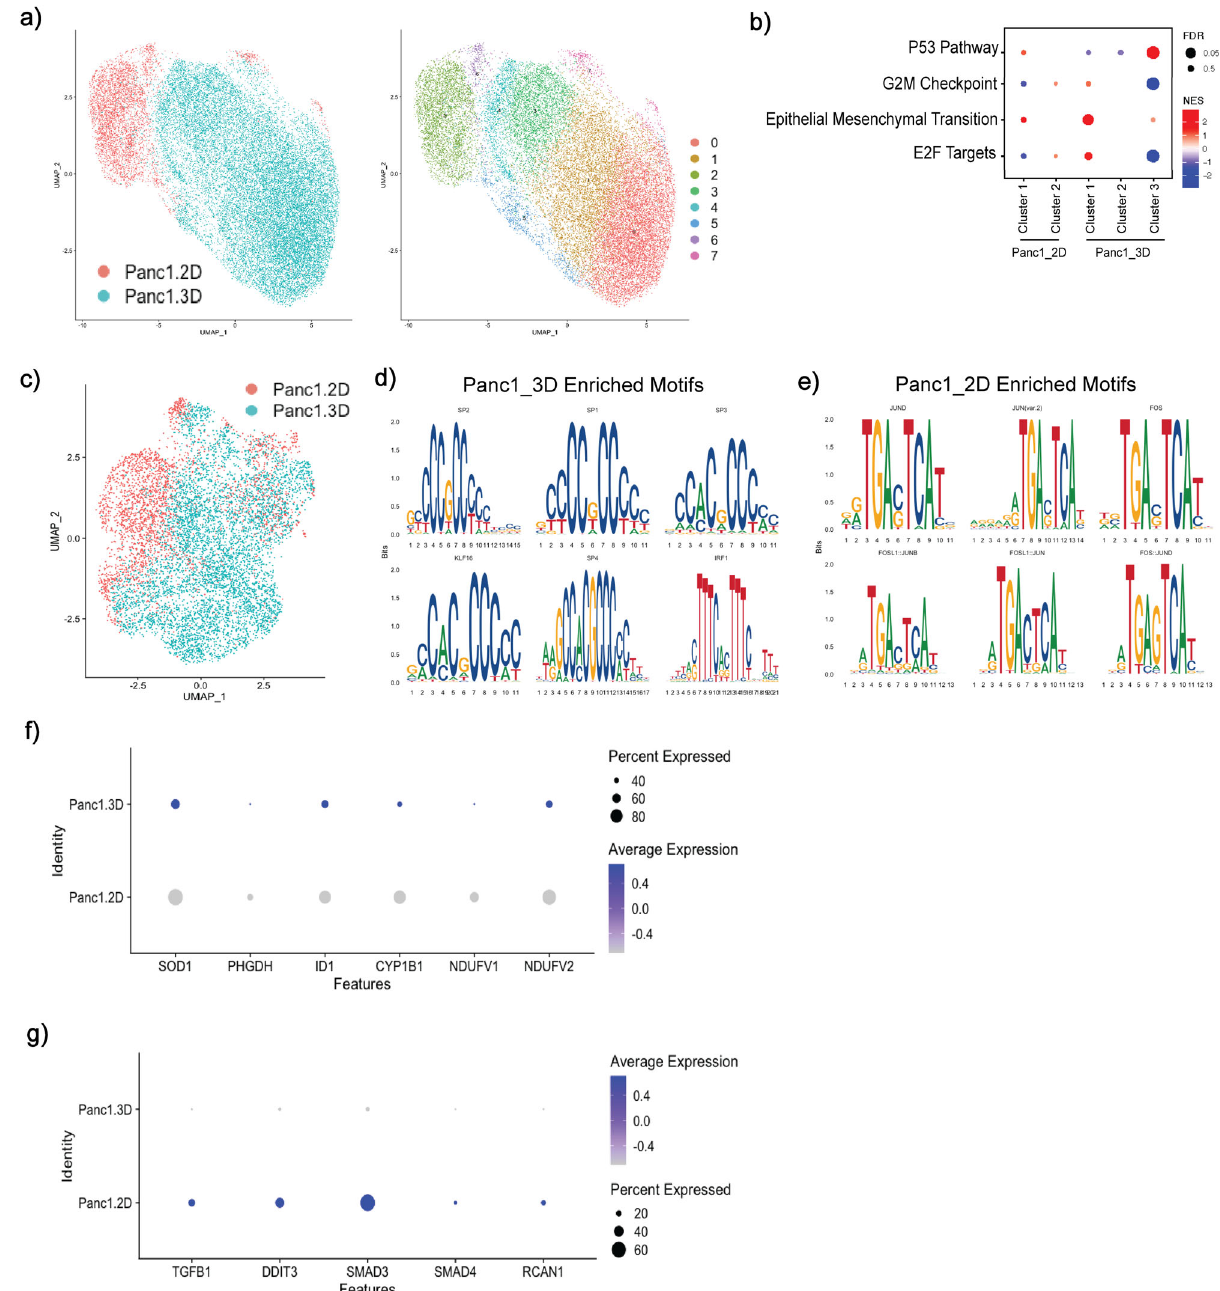
Fig. 5 Spheroid growth model promotes transcriptional heterogeneity and epigenetic remodeling. a UMAP overlaying scRNA of Panc1 samples and their unique clusters. b Pathway enrichment pro fi les de fi ned by GSEA analysis for Panc1-2D and Panc1-3D spheroid cell clusters. Size of dot represents FDR, red indicates upregulation, blue indicates downregulation of the pathway. c UMAP representing snATAC-seq data of merged Panc1 samples. d , e Analysis of merged Panc1 snATAC data shows enrichment in Sp/Klf motifs in spheroid data, and enrichment of Fos/Jun motifs in 2D monolayer culture. f Comparison of expression of genes associated with Sp/Klf transcription factors in scRNA of Panc1 2D and Panc1 3D. g Comparison of expression of genes associated with Fos/Jun transcription factors in scRNA of Panc1 2D and Panc1